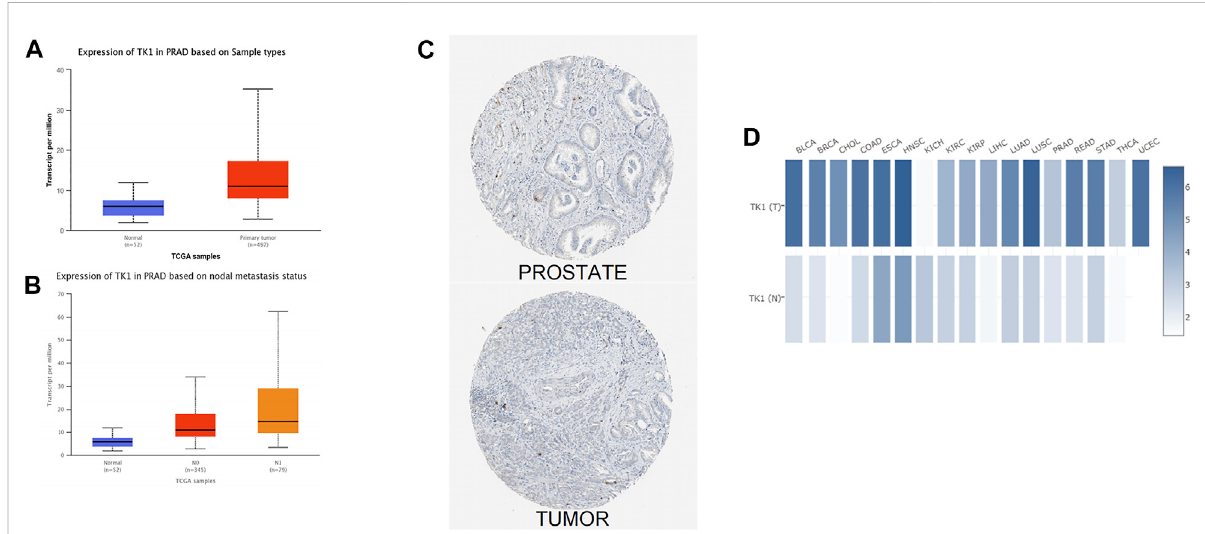
FIGURE 1 Overexpression of TK1 in PCa. (A) TK1 expression levels in various human malignancies were analyzed by TIMER. (B) UALCAN analyzed TK1 mRNA levels in tumor tissues and nontumorous tissues. (C) The expression of TK1 mRNA between different nodal metastasis statuses of PCa tissues wasanalyzedby UALCAN. (D) Differential proteinexpressionofTK1 intumor and nontumoroustissues intheHPA. (E) GEPIA analyzed high or low expression levels of TK1 in various malignant